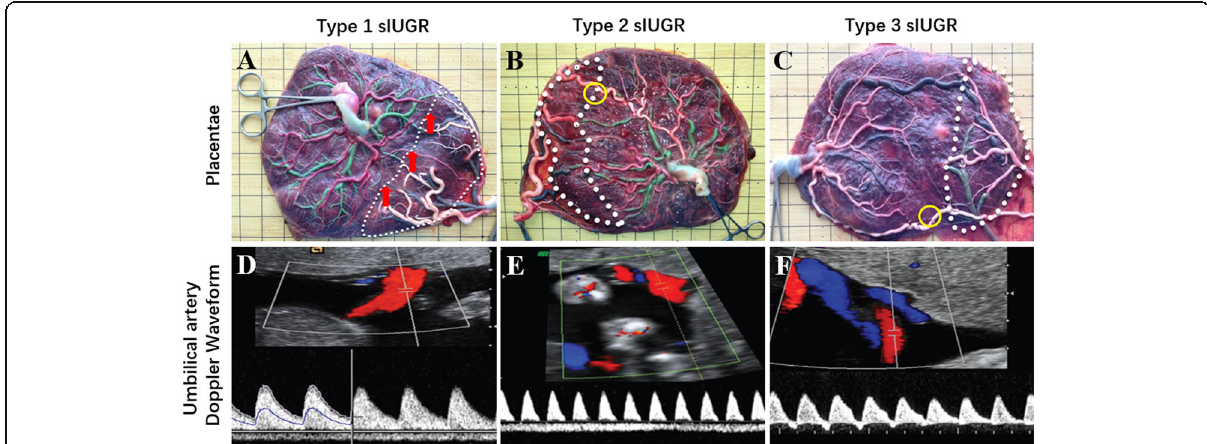
Fig. 1 Classifications of type 1, type 2, and type 3 selective intrauterine growth restriction (T1& T2&T3 sIUGR) in monochorionic twins via placental sharing, velamentous cord insertion, anastomoses, and umbilical artery flow. The white dotted lines connect the smallest diameter vascular anastomoses points on the surface of the chorionic plate and divide the placenta into larger and smaller twin portions. The red regions in the d , e , and f indicate that the blood flow of umbilical artery directs toward the ultrasound probe. The blue regions in the e , f show that the direction of blood flow in the umbilical artery is opposite to the ultrasound probe. a T1 sIUGR placenta - placenta was infused with placental vascular dye injection. This displays unequal placental sharing and discordance cord insertion as the features of sIUGR placenta, but vascular anastomoses remain similar to uncomplicated monochorionic twins. b T2 sIUGR placenta - large arterioarterial anastomoses (2 ≥ mm, yellow circle) are present the umbilical artery Doppler waveform has positive end-diastolic velocity in the umbilical artery. e In T2 sIUGR, there is absent or reversed end- diastolic flow (AREDF) in the umbilical artery. f In T3 sIGUR, there is a cyclical or intermittent pattern of AREDF in the umbilical